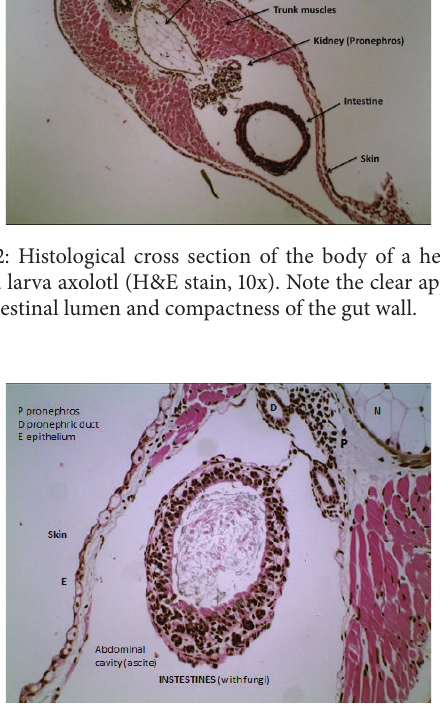
Figure 3: Histological section showing the intestine of an infected axolotl larva (10 weeks old). Note the presence of fungi in the intestinallumenandthethickeningoftheintestinalwall(H&Estain,